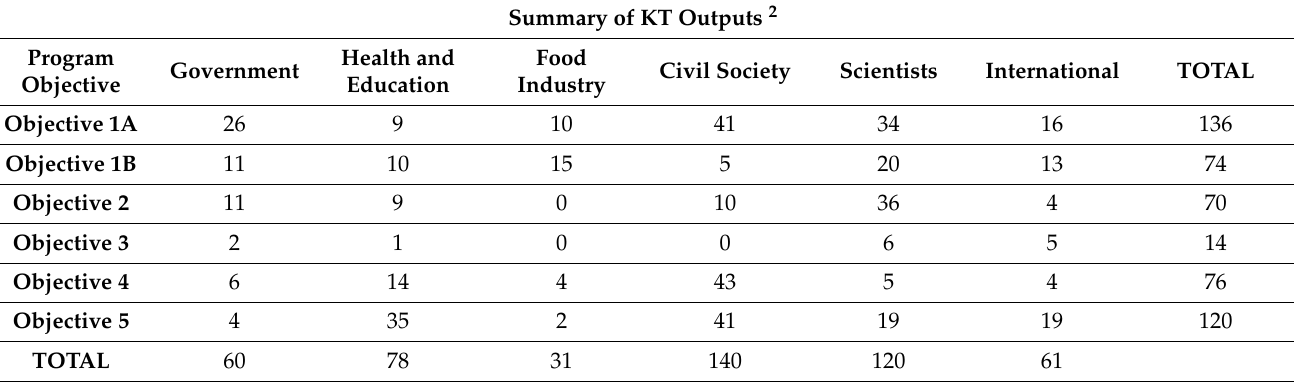
Table 2. Summary of the reach of KT outputs across different target